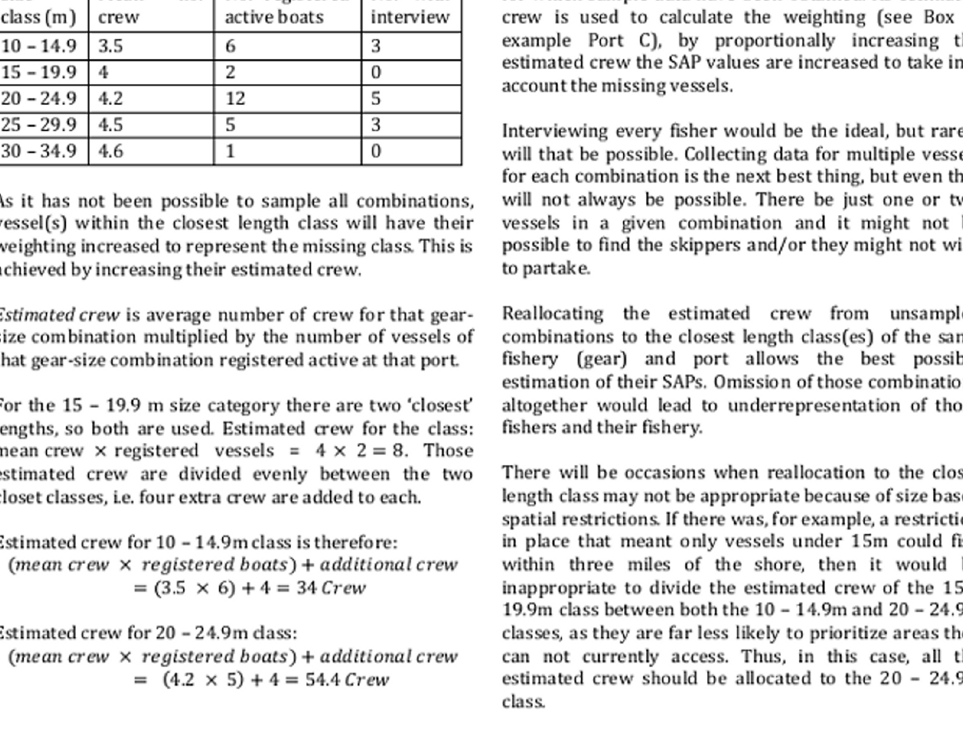
Figure 6. Illustrative example of SAPM when not all gear-port-size combinations have been sampled.